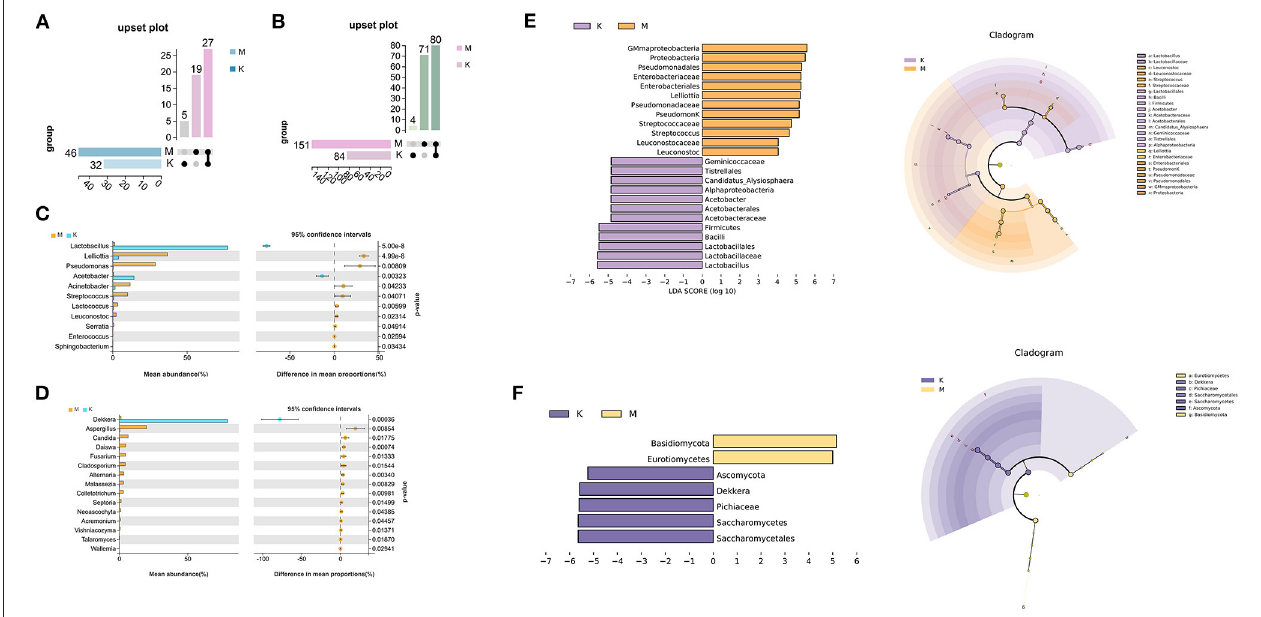
FIGURE 4 | Distribution of indicator species before and after mare’s milk fermentation. (A,B) Upset diagrams of bacteria and fungi at the genus level, respectively. (C,D) Welch’s t -test of bacteria and fungi at the genus level, respectively. The left half of the ordinate represents the difference species, the abscissa represents the mean species abundance; the right half of the abscissa represents the difference in abundance between groups, the dot color represents the group with higher abundance, and the error bar of the dot represents the difference 95%. The fluctuation range of the confidence interval, and the ordinate represents the significance of the difference between the corresponding species groups, that is, the size of the p -value. (E,F) LEFSe analyses of bacteria and fungi, respectively. The LDA score plot shows the biomarkers of different groups, and the length of the histogram represents the impact size of the different species. In the clade diagram, each small circle at a different taxonomic level represents a species at that taxonomic level, and the diameter of the small circle is proportional to the relative abundance.